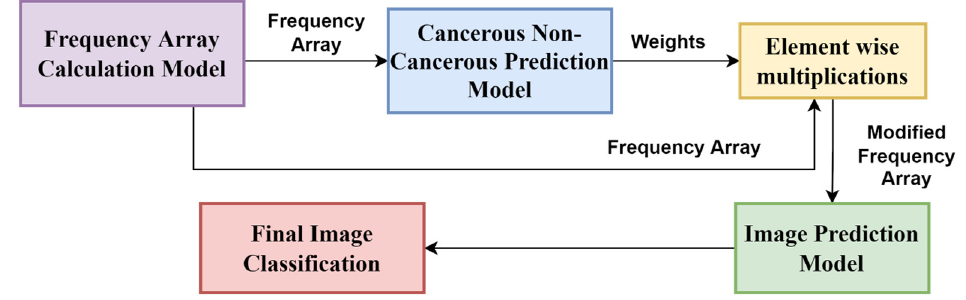
Figure 9. Image classification model using patch-prediction probabilities.